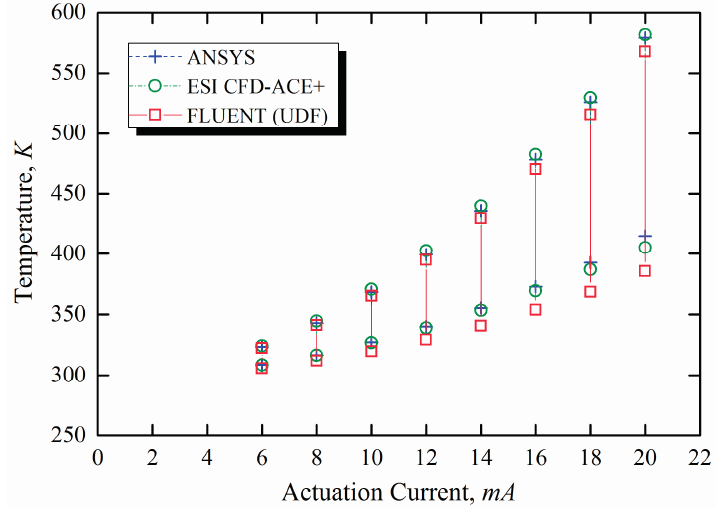
Figure 6. Numerically estimated temperature range of microcantilever heated in air.